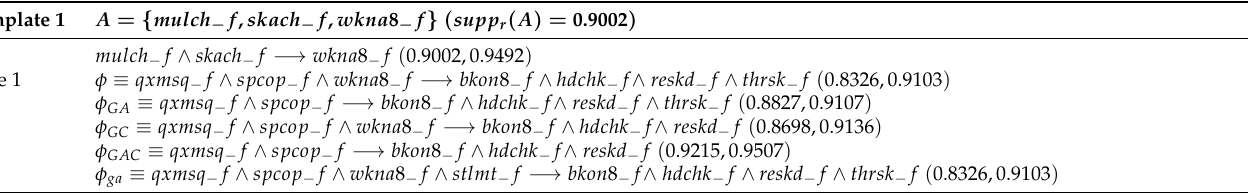
Table A12. Templates, association rules and generalized association rules in the chess